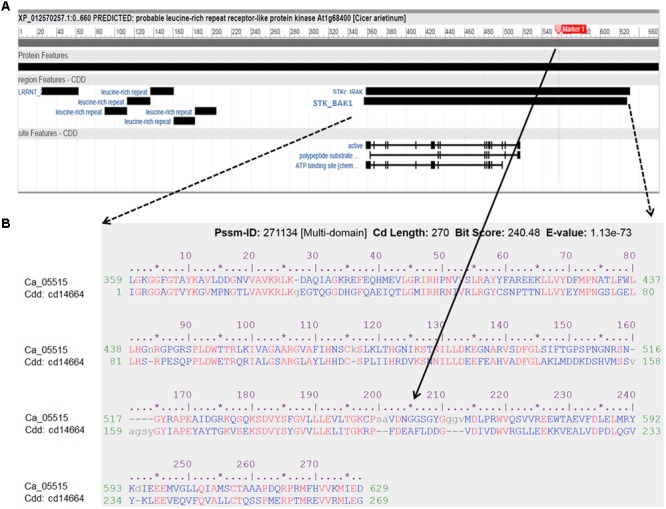
Characterization of the LRR receptor-like kinase (Ca_05515/XP012570257) and its conserved domains cd14664. (A) Schematic diagram of the protein features of the LRR receptor-like kinase. Black boxes indicated specific conserved domain regions. LRRNT: N-terminal domain of LRR; STK_BAK1: kinases domain of brassinosteroid (BR)-associated kinase (BAK1). (B) Alignment of amino acid sequence of the LRR receptor-like kinase with the best hit conserved domain STK_BAK1. The SNP (Ca4: 15,920,939) with significant association with AB resistance, located in the STK_BAK1 leading to amino acid substitution (Gly/Ala), is highlighted as Marker 1 and indicated in the alignment.